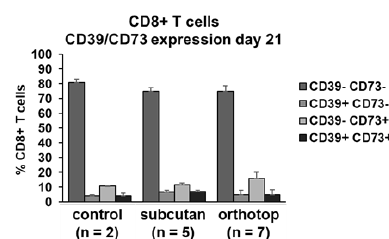
Figure 6. Cell populations in the spleen of orthotopic and subcutaneous HNSCC-bearing mice. ( A – C ) Populations of B cells and subgroups of B cells were analyzed using flow cytometry. ( D , E ) The expression profile for IgM/IgD and CD39/CD73 was determined on B cells. ( F , G ) Populations of CD4 + and CD8 + T cells were analyzed using flow cytometry. ( H , I ) The expression profile for CD39/CD73 was determined on T cells. Absolute cell numbers and percentages were calculated based on absolute and relative lymphocyte numbers. Values are shown for day 0 (control), day 7, day 14, and day 21. The test group size for the subcutaneous group is on day 7 is n = 6, day 14 n = 6, and day 21 n = 5. The test group size for the orthotopic group on day 7 is n = 8, day 14 n = 7, and day 21 n = 7. The test group size of the control group n = 2 on all days. p -values < 0.05 were considered to be significant with (*). Data shown here are listed in Table S3.